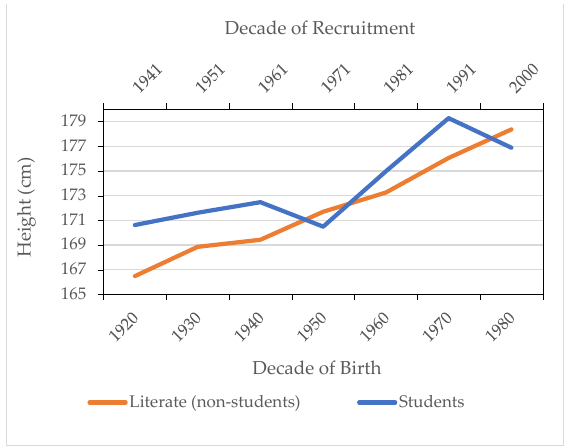
165167169171173175177179